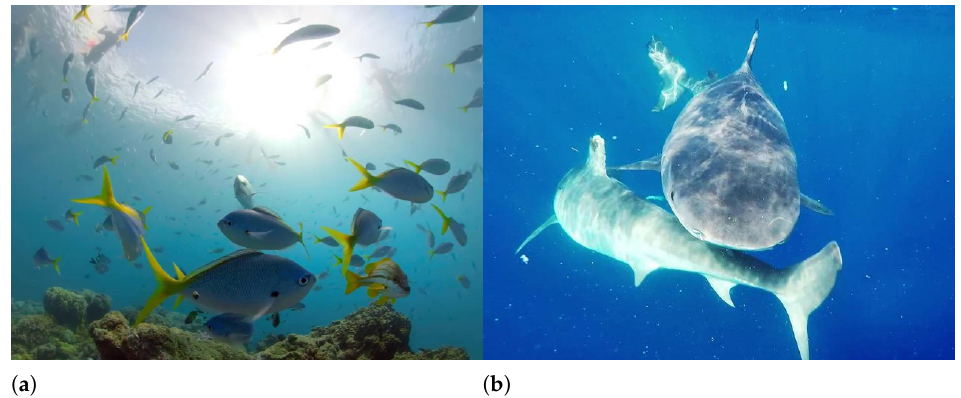
Figure 7. Bliinds2, UIQM and FDUM misjudgment example. ( a ) Bliinds2(DMOS)=20 UIQM = 0.93